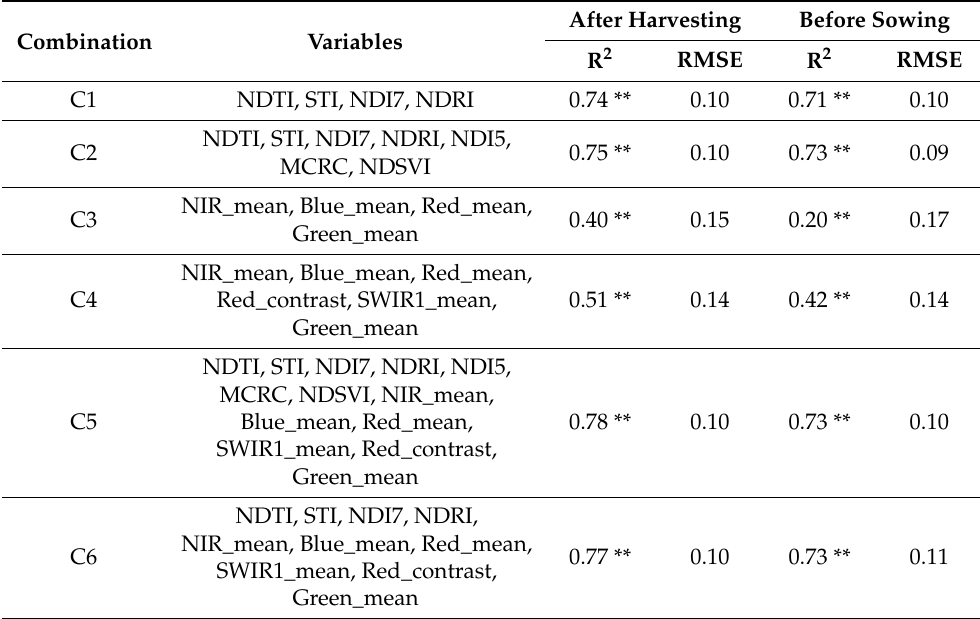
Table 5. A comparison of multiple linear regression for estimating CRC using different features. Combination